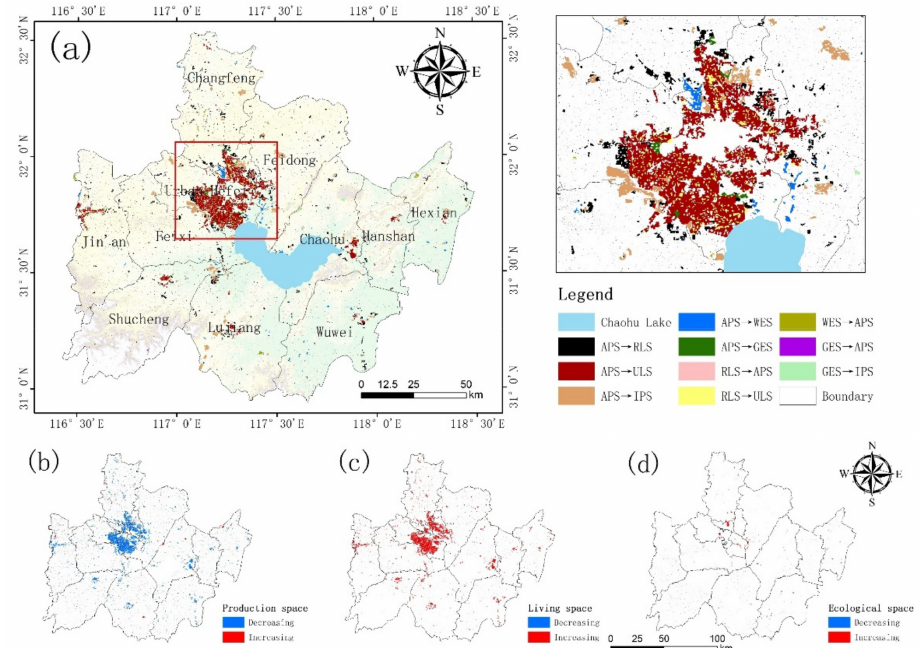
Figure 6. ( a ) shows the secondary space transfer from year 2000 to 2020; ( b ) shows the increase and decrease distribution of production; ( c ) shows the increase and decrease distribution of living; ( d ) shows the increase and decrease distribution of ecological